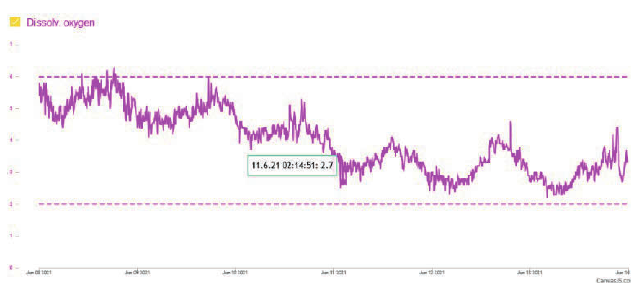
Fig. 9. The level of dissolved oxygen with the corresponding threshold